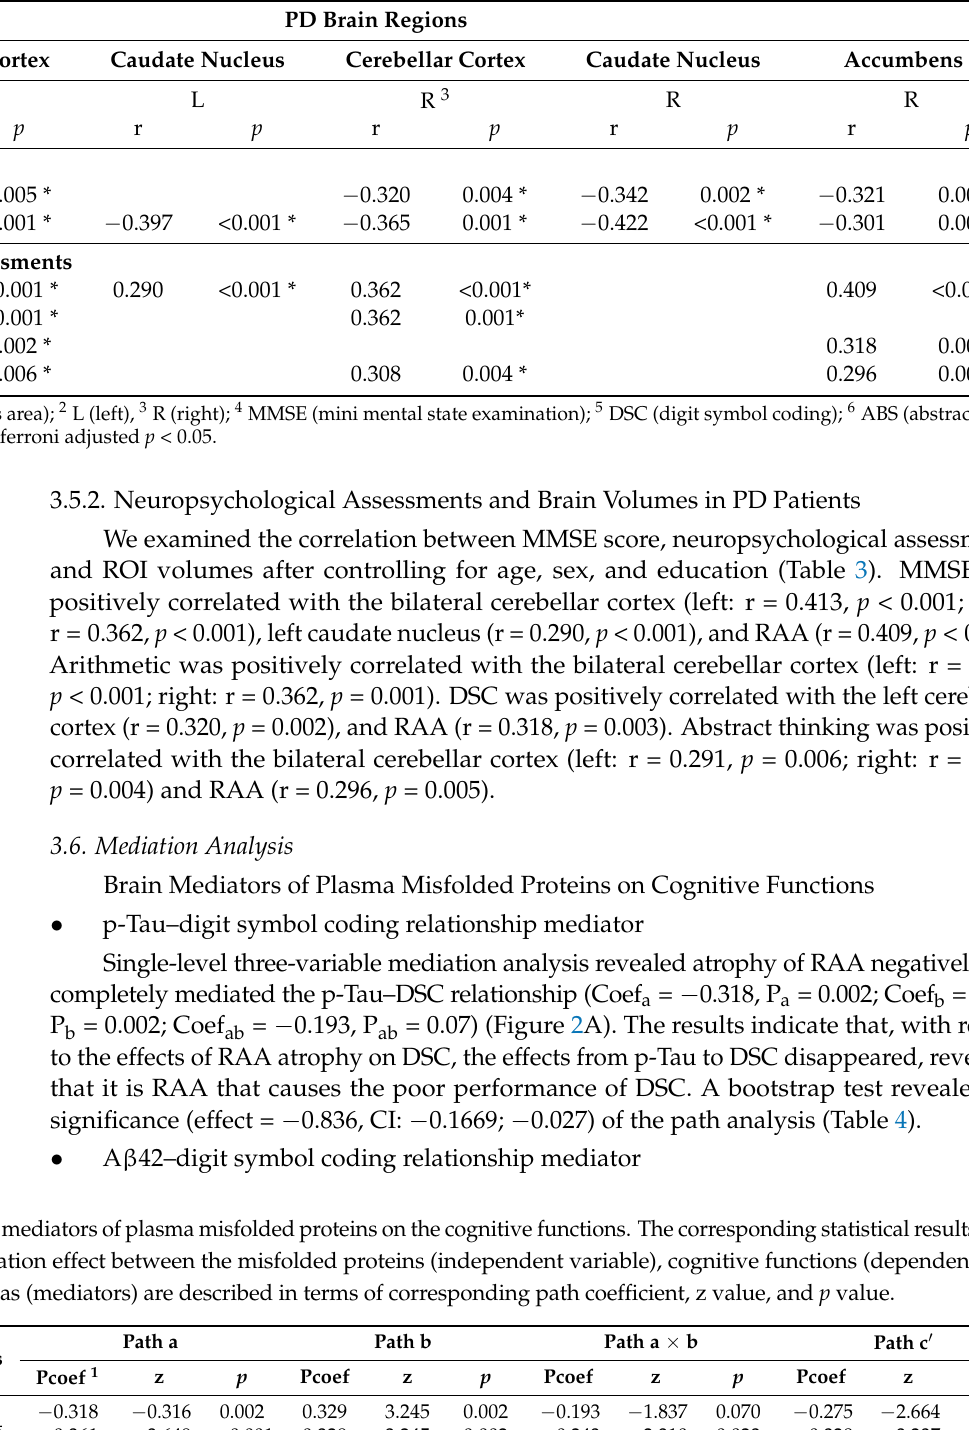
Table 3. Correlation analysis of levels of plasma misfolded protein, neuropsychological assessments, and deep gray matter atrophy in PD group after controlling age, sex, and education level. The brain volumes were corrected by intracranial volumes.